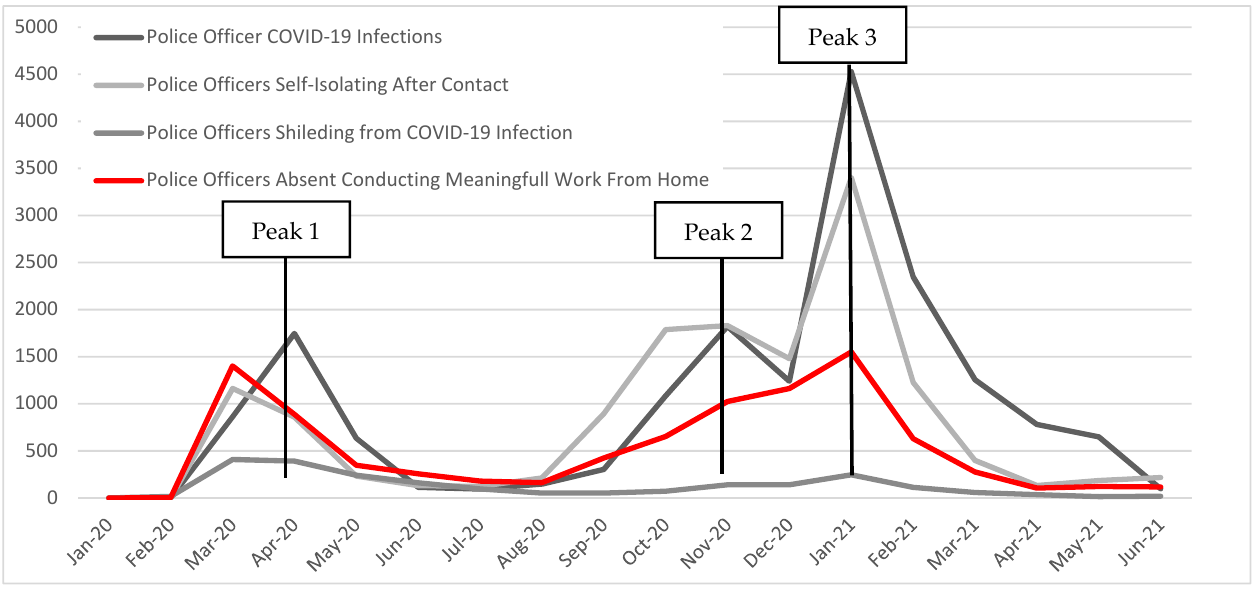
Figure 4. Reported police officer absences and peak infection periods vs. police officers conducting meaningful work.